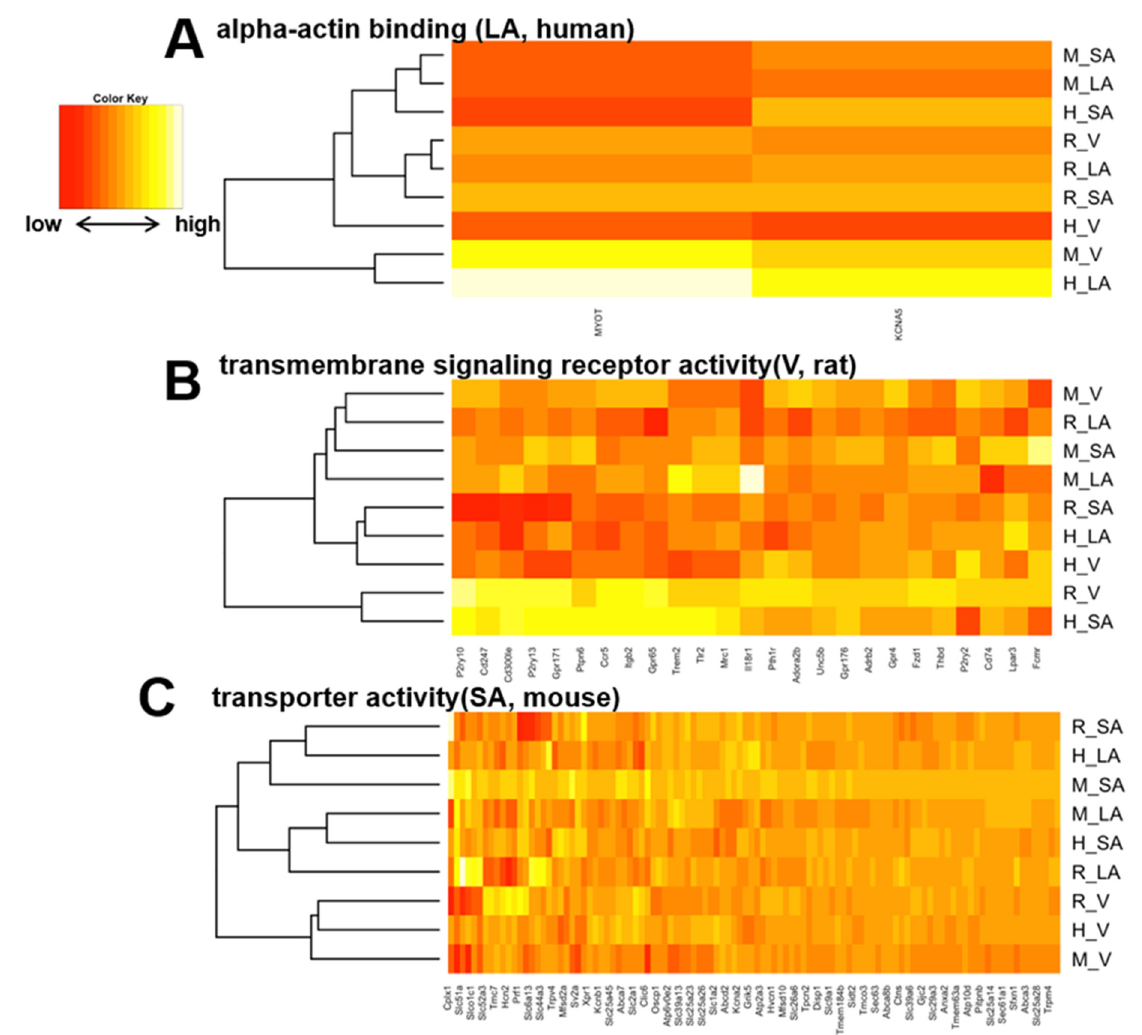
Figure 7. ( A ), A heat map of the human-selective LA-specific genes with the representative enriched gene ontology. Similarly, ( B ) and ( C ) show representative rat ventricle-specific ontologies and mouse SA-specific ontologies, respectively.